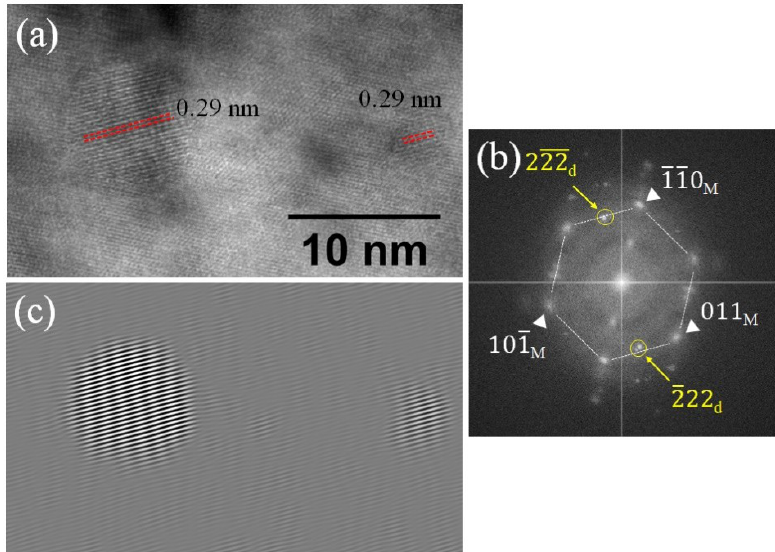
Figure 4. ( a ) High-resolution TEM (HRTEM) of two oxide dispersoids, ( b ) fast Fourier transform (FFT) patterns from the HRTEM, and ( c ) inverse FFT image of dispersoids using FFT patterns in yellow circles. The d -spacings measured from HRTEM and FFT patterns are 0.29 nm, which agree with (222) of pyrochlore Y 2 Ti 2 O 7 . The scale bar in (a) applies to (c).